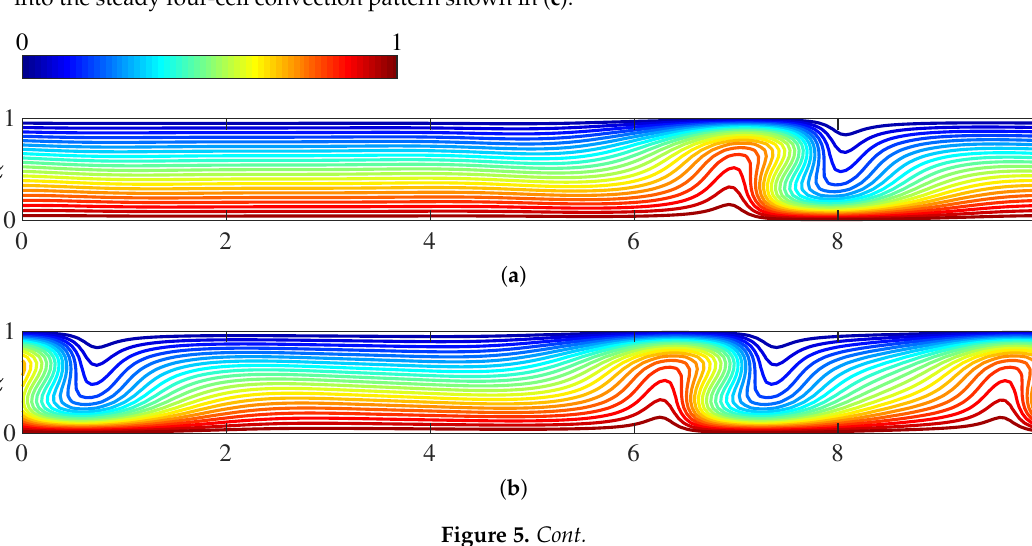
Figure 4. Snapshots of isotherms (left) and corresponding streamlines (right) from numerical simulations at Ra = 500 and L = 2. ( a ) φ = 0 ◦ ; ( b ) φ = 10 ◦ ; ( c ) φ = 15 ◦ . For φ < 15 ◦ , the convection appears in the form of unsteady rolls ( a , b ). However, as φ is increased, the boundary-layer instability of the antinatural roll (negative ψ ) becomes stronger and splits the unsteady two-cell convective state into the steady four-cell convection pattern shown in ( c ).